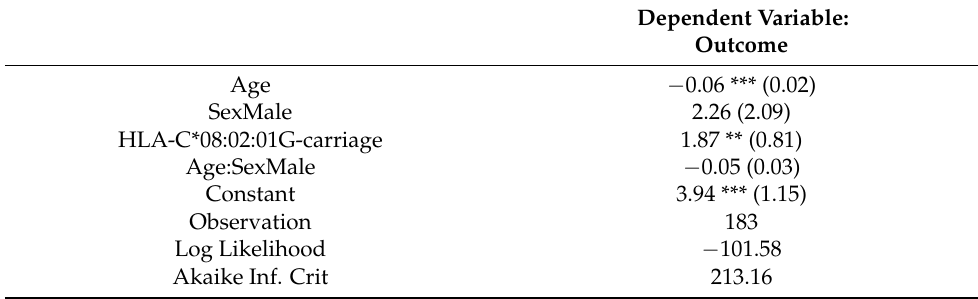
Table 11. Coefficients for one-allele (HLA-C*08:02:01G) model.